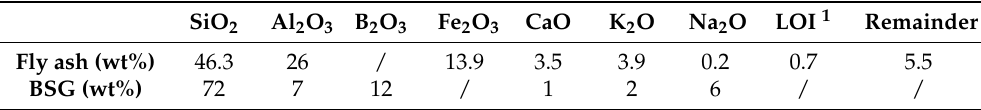
Table 2. Chemical compositions of raw fly ash and recycled BSG glass